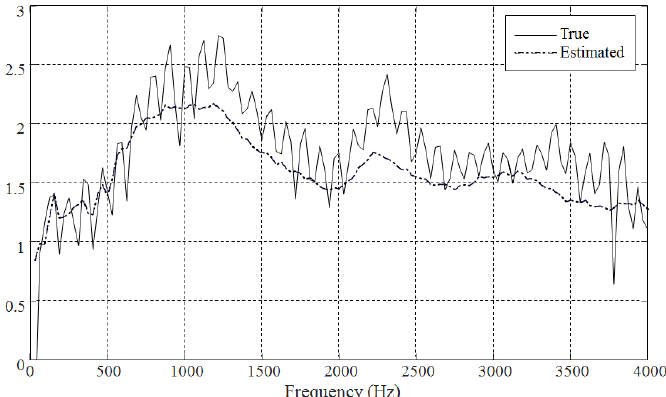
Figure 2. Examples of original (bold line) and the predicted (dotted line) speech Fig. 2. Examples of original (bold line) and the predicted (dotted line) speech spectra. Table 1. Pitch estimation accuracy for each modality.